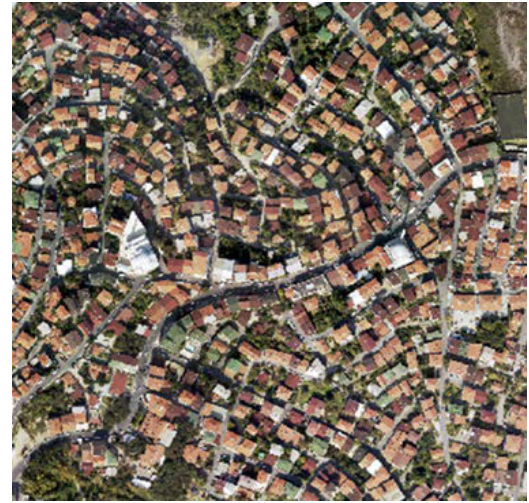
Figure 4. Airborne LiDAR point cloud.